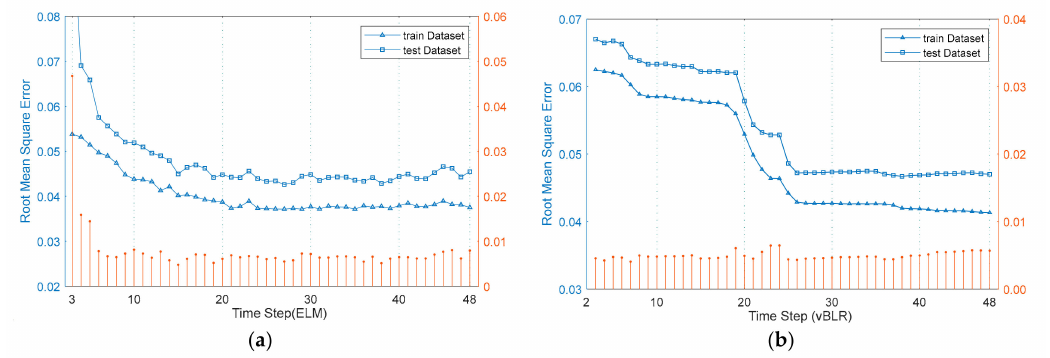
Figure 6. RMSE of ELM and vBLR when k takes di ff erent values. ( a ) The RMSE of ELM; ( b ) The RMSE of v SVR.